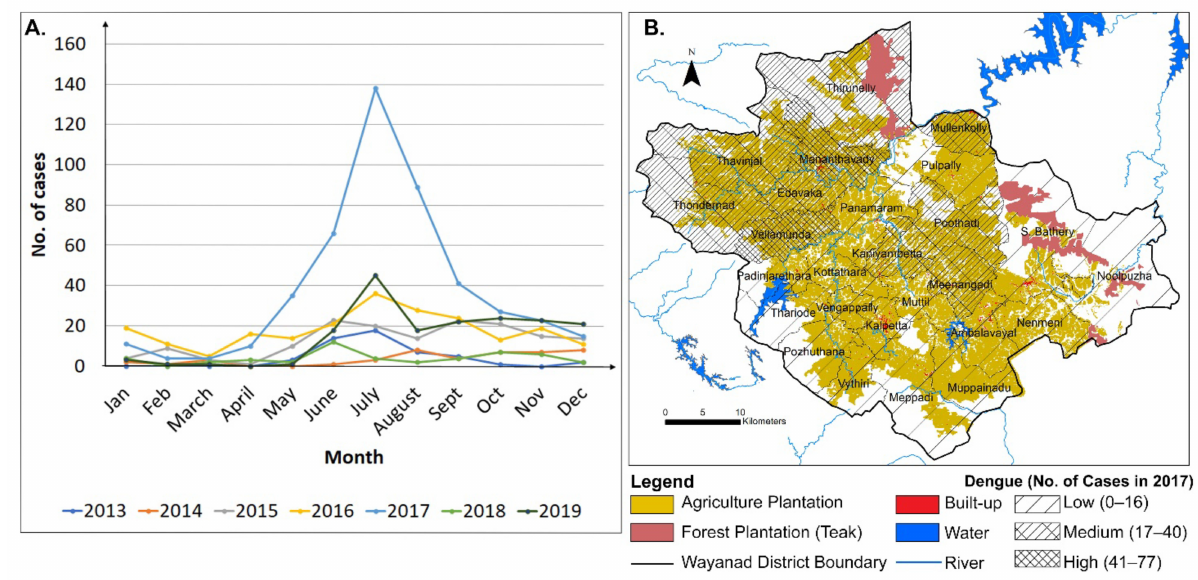
Figure 5. ( A ) Month wise dengue cases in Wayanad district for the time 2013–2019, and ( B ) thematic map showing Gram Panchayat wise dengue cases in 2017 superimposed on plantation